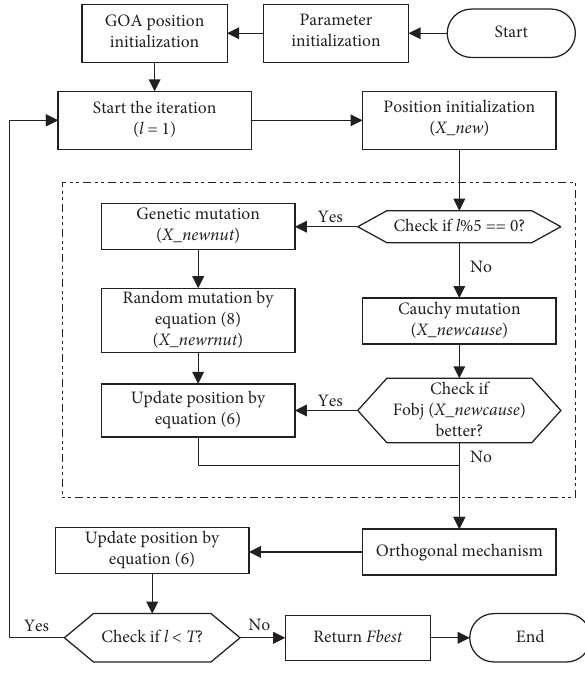
Figure 1: The flowchart of